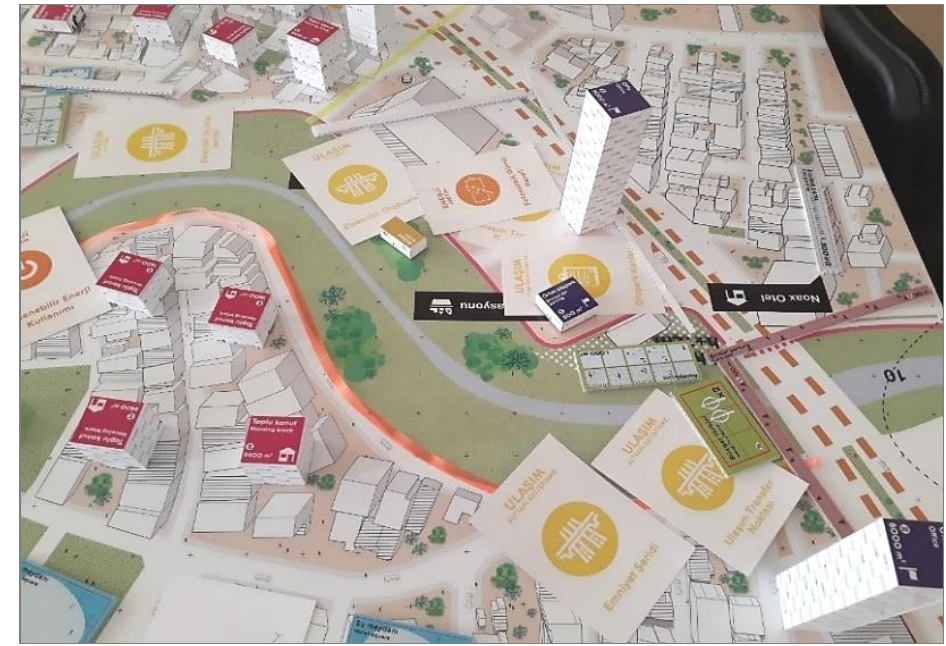
Figure 9 Utilization of all game utilities and props onto the game board during game sessions with